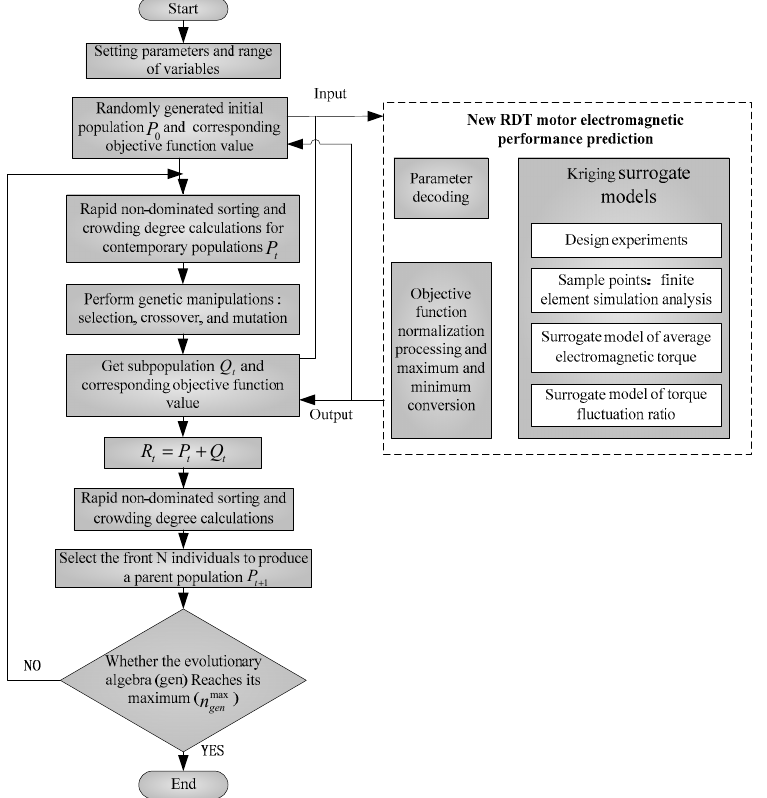
Figure 18. Flowchart of the multi-objective optimization design method combining NSGA-II, the Kriging method and FEM.